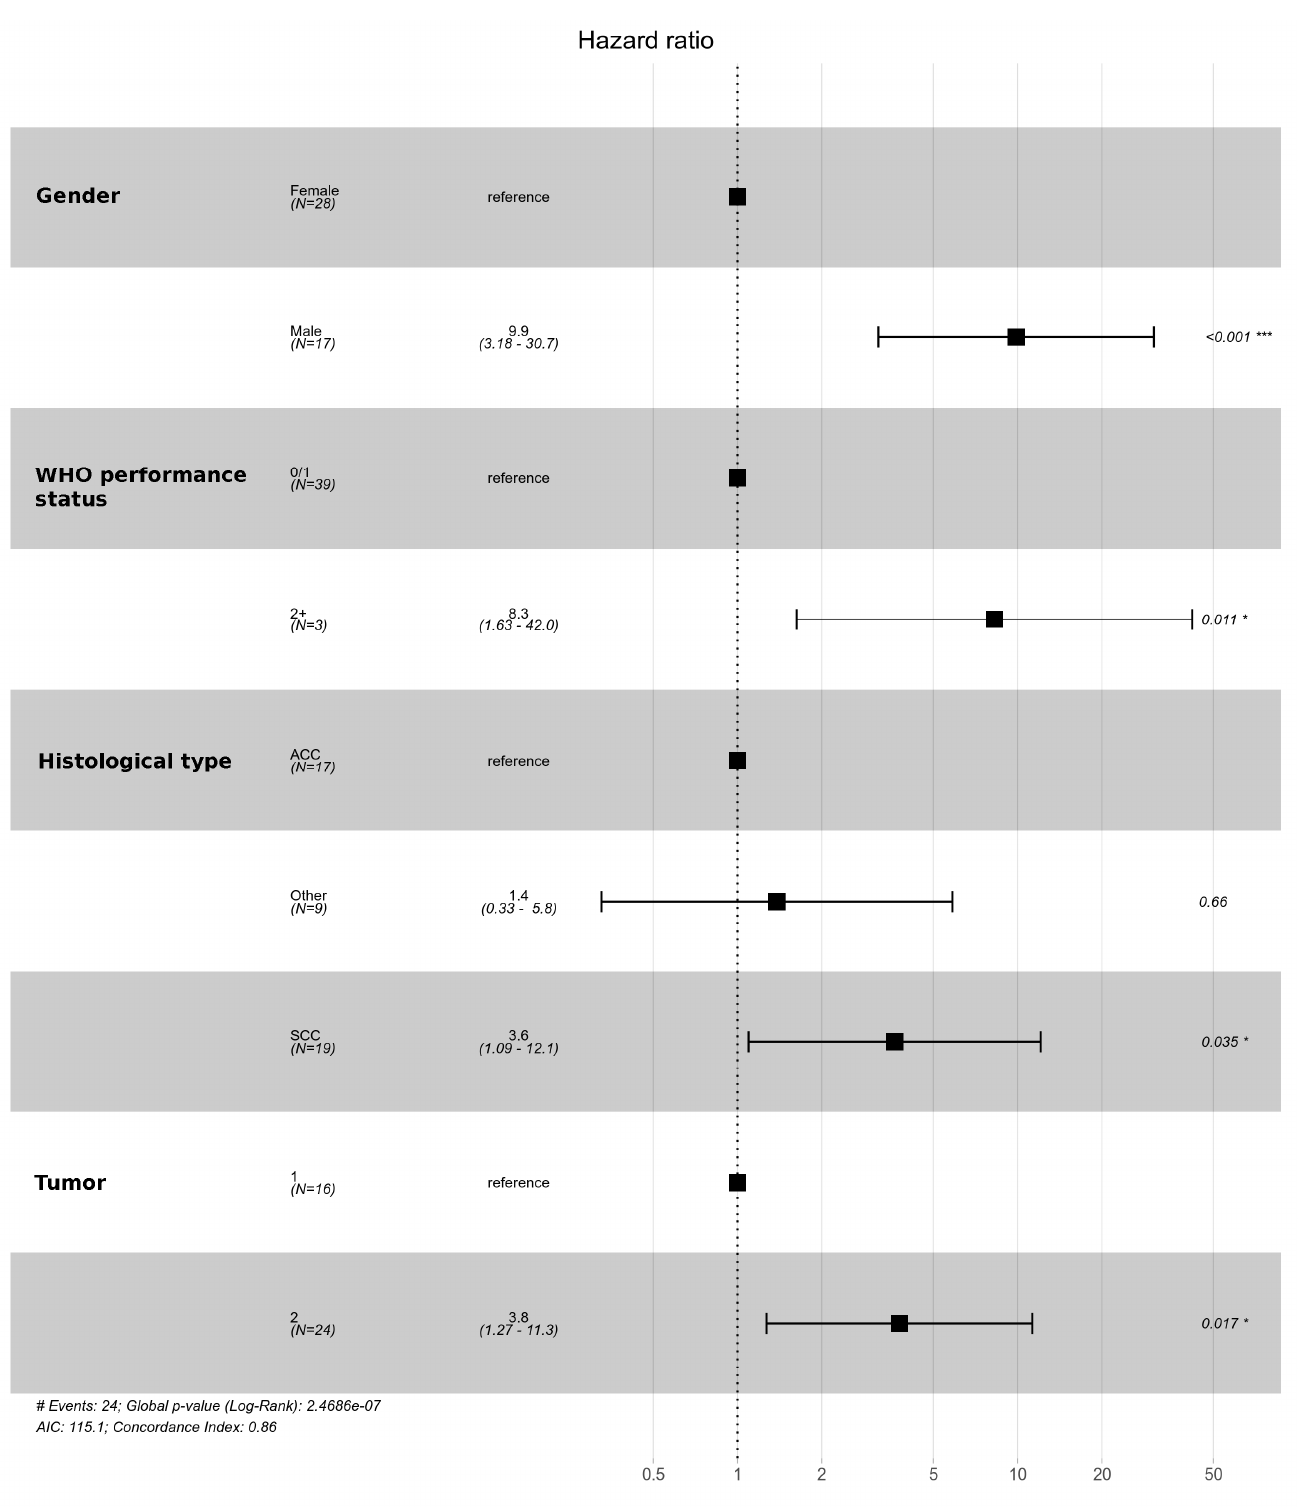
Figure 6. Multivariate analysis for overall survival among radically treated patients. Significant codes legend: from 0 to 0.001 “***”; from 0.01 to 0.05 “*”.